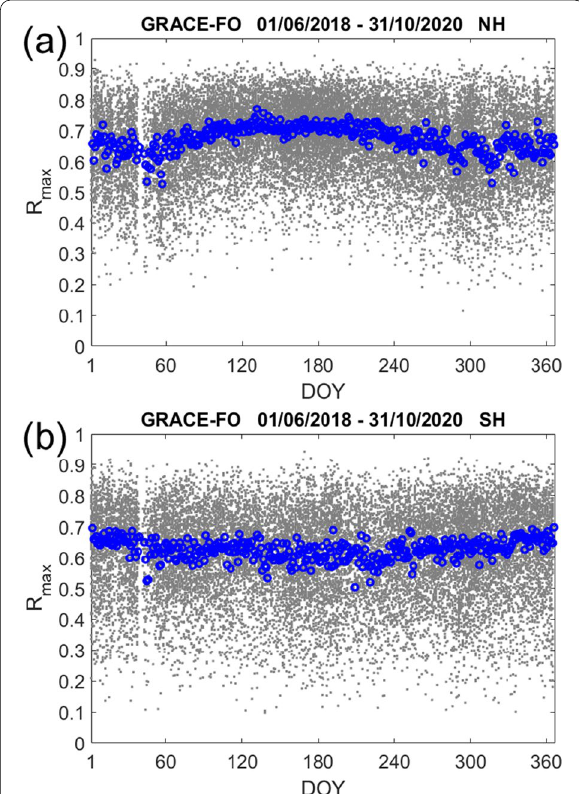
Fig. 6 Similar to Fig. 5, but for the distribution of R max on